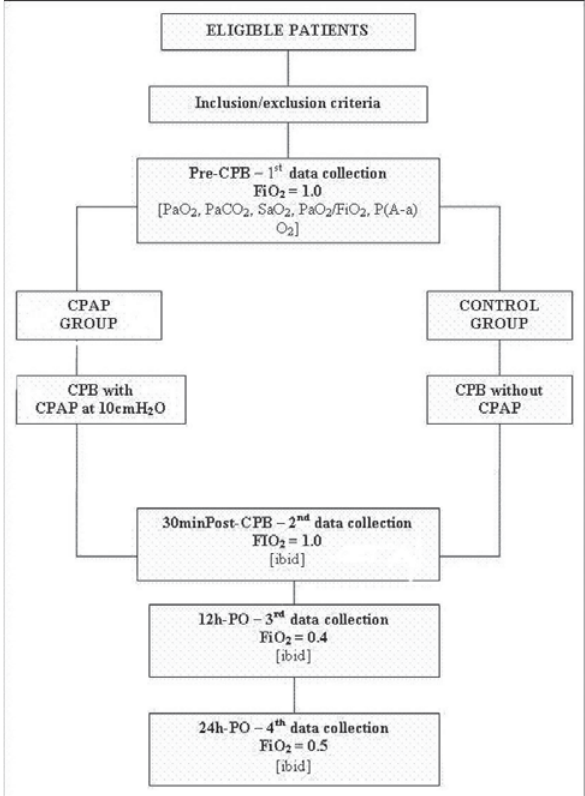
Fig. 1 - Study protocol diagram. - CPB = cardiopulmonary bypass; CPAP = continuous positive airway pressure; FiO oxygen fraction; PaCO = arterial carbon dioxide partial pressure; 2 = arterial oxygen partial pressure; PO = postoperative; PaO 2 SaO = arterial oxygen 2